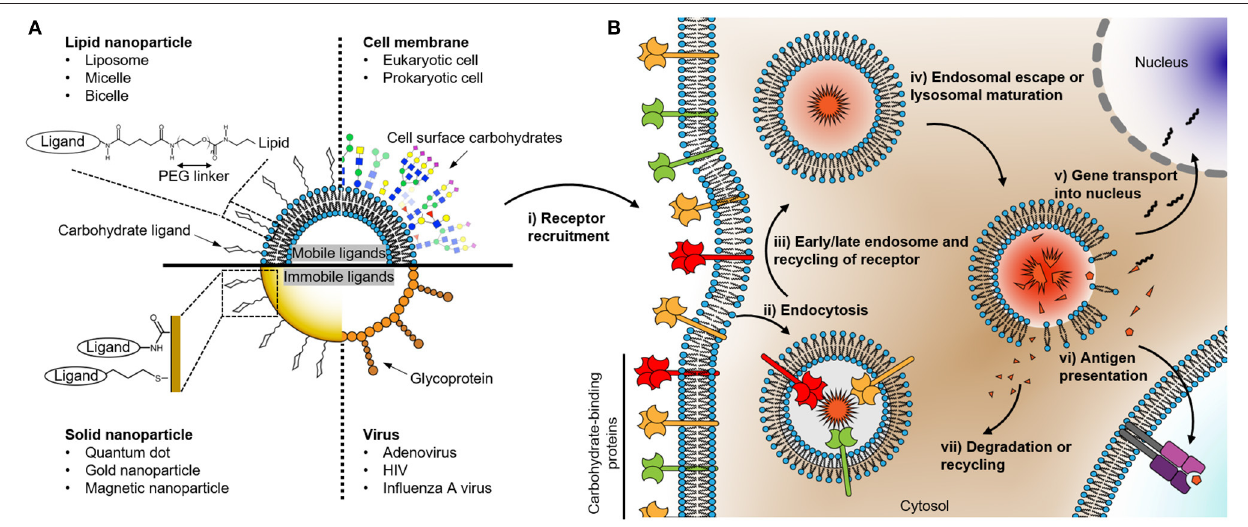
FIGURE 1 | (A) Schematic drawing of nanoparticles coated with carbohydrates recognized by cell surface receptors. The right and left parts of the quadrants describe the surface structure of various organisms and their synthetic surrogates with representative conjugated ligand structures on the surfaces, respectively. The composition of the nanoparticle determines its chemo-physical properties which in turn affect the mobility, distribution, and localization of carbohydrate or glycoprotein ligand presented on the surface of the particle. (B) Uptake and degradation of carbohydrate organism in an antigen-presenting cell. The events following the recognition of the nanoparticle by the carbohydrate binding receptors consist of several steps: (i) receptor recruitment; (ii) endocytosis; (iii) endosomal maturation; (iv) the escape of cargo or degradation; the cargo can be either (v) transported into the nucleus in the case of a DNA or (vi) presented as an antigen on the cell surface. Finally, (vii) degradation or recycling of the